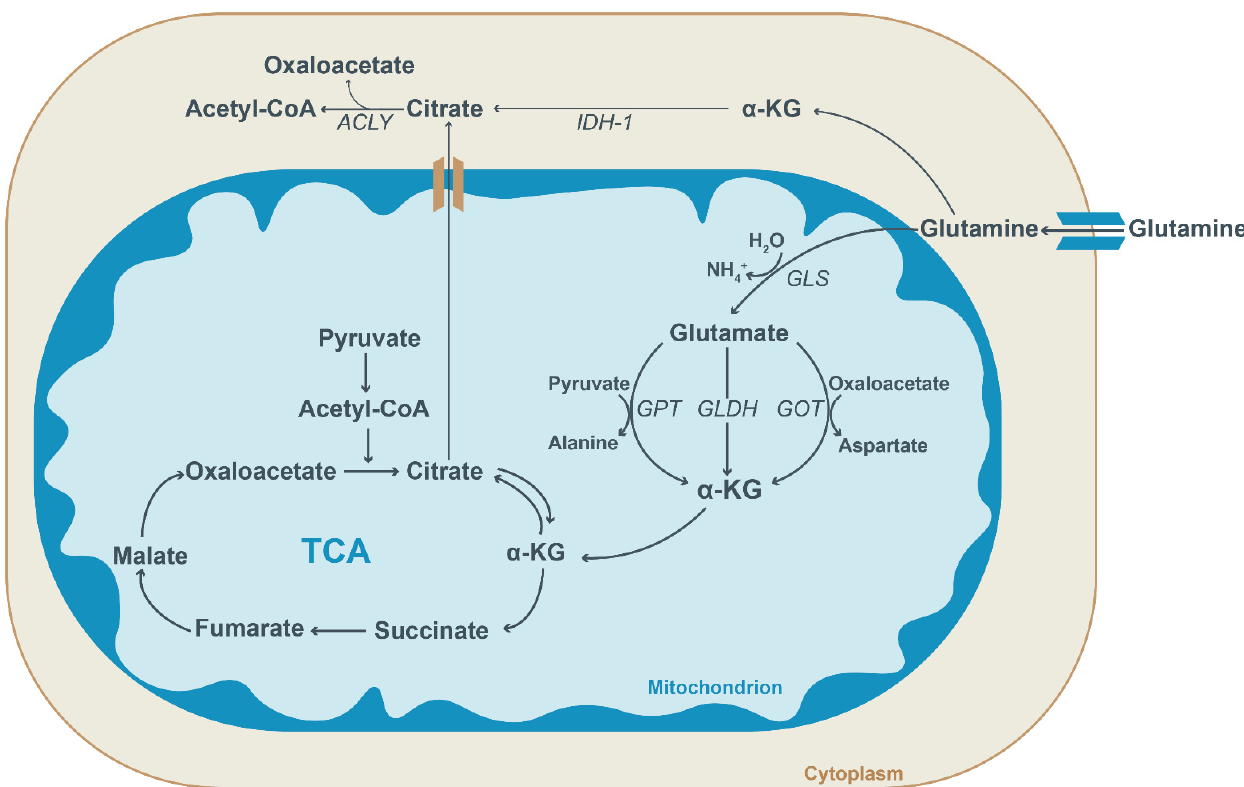
Figure 3. Schematic overview of glutamine metabolism. In the cytosol, glutamine is converted into alpha-ketoglutarate ( α -KG) or transported into mitochondria. Within the mitochondria, glutamine is first converted into glutamate by glutaminase (GLS) and then to α -KG. Glutamate conversion into α -KG is facilitated by three enzymes: glutamate pyruvate transaminase (GPT), glutamate dehydrogenase (GLDH) and glutamate oxaloacetate transaminase (GOT). Subsequently, α -KG enters the TCA cycle and aids the generation of succinate, thereby replenishing the TCA cycle (anaplerosis). Alternatively, it can be used to generate citrate (reductive carboxylation) which can be transported to the cytosol. In the cytoplasm, isocitrate dehydrogenase (IDH-1) facilitates the conversion of α -KG into citrate. Citrate is utilized for acetyl-CoA and oxaloacetate generation by ATP-citrate lyase (ACLY). Cytosolic acetyl-CoA forms the substrate for lipogenesis and the acetylation of proteins. The role of glutaminolysis in the heart has not been clearly defined. Under normal conditions, the role of glutamine in the anaplerosis of the TCA cycle intermediates seems limited [107]. However, cardiac glutaminolysis was shown to be activated in a rat model of right ventricular hypertrophy [108]. Notably, the induction of transporters and enzymes involved in glutamine handling is Myc-dependent, again pointing to an important role of this oncogene in metabolic rewiring